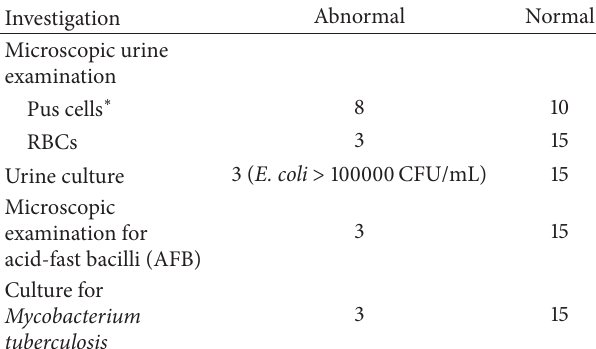
Table 1: Urine analysis ( 𝑛 = 18